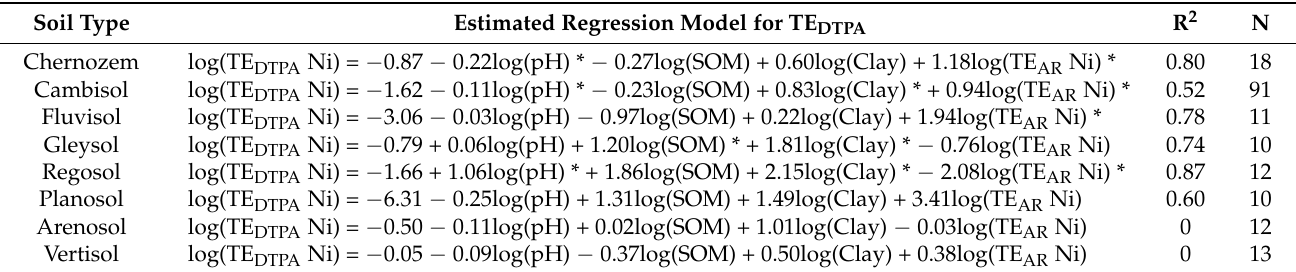
Table 9. Prediction model 6.